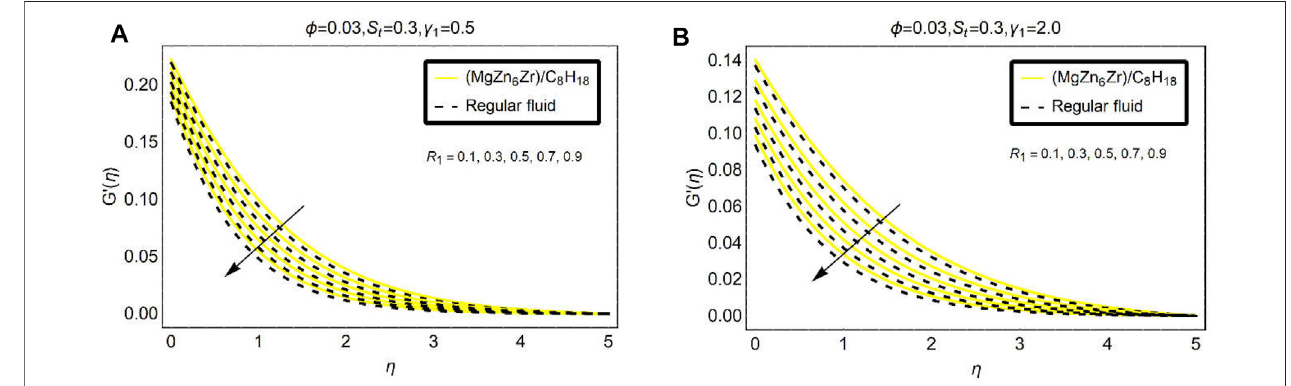
FIGURE 6 | Velocity G ’ via R 1 (A) γ 1 (cid:2) 0 . 5 and (B) γ 1 (cid:2) 2 . 0.